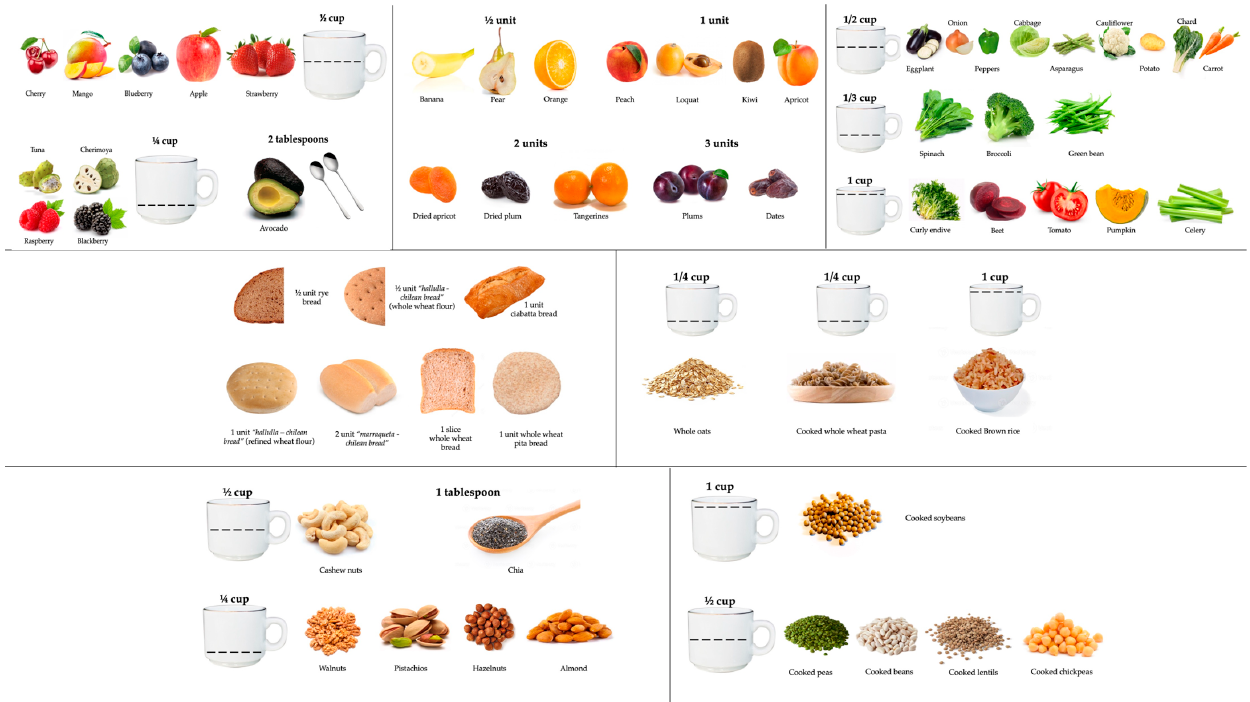
Figure 2. Representative images of each food group, according to the Photographic Atlas of Typical Chilean Preparations.